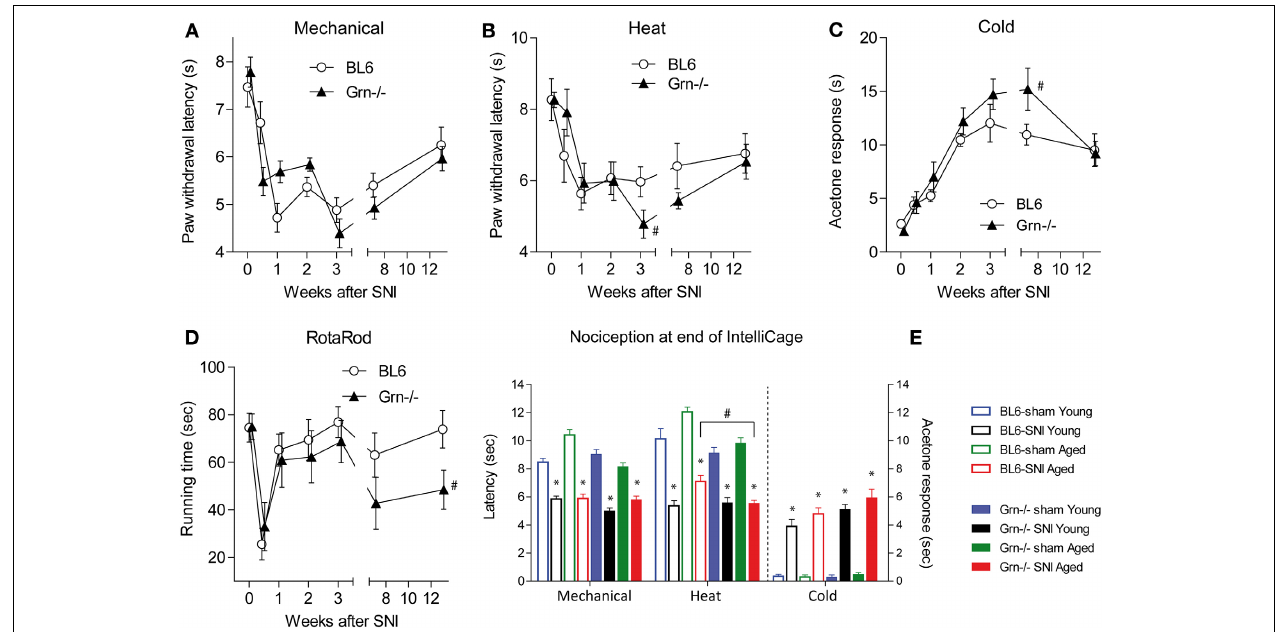
SNI. (E) Nociceptive behavior at the end of the IntelliCage experiments after sham or SNI surgery in young and aged C57BL6/J and progranulin deficient mice. The asterisks ( ∗ ) denote significant differences between the respective SNI and sham treated mice, and the crosses (#) show significant differences between genotypes, P < 0 . 05. Data are means ± s.e.m. of n = 8–12 per group for all tests.